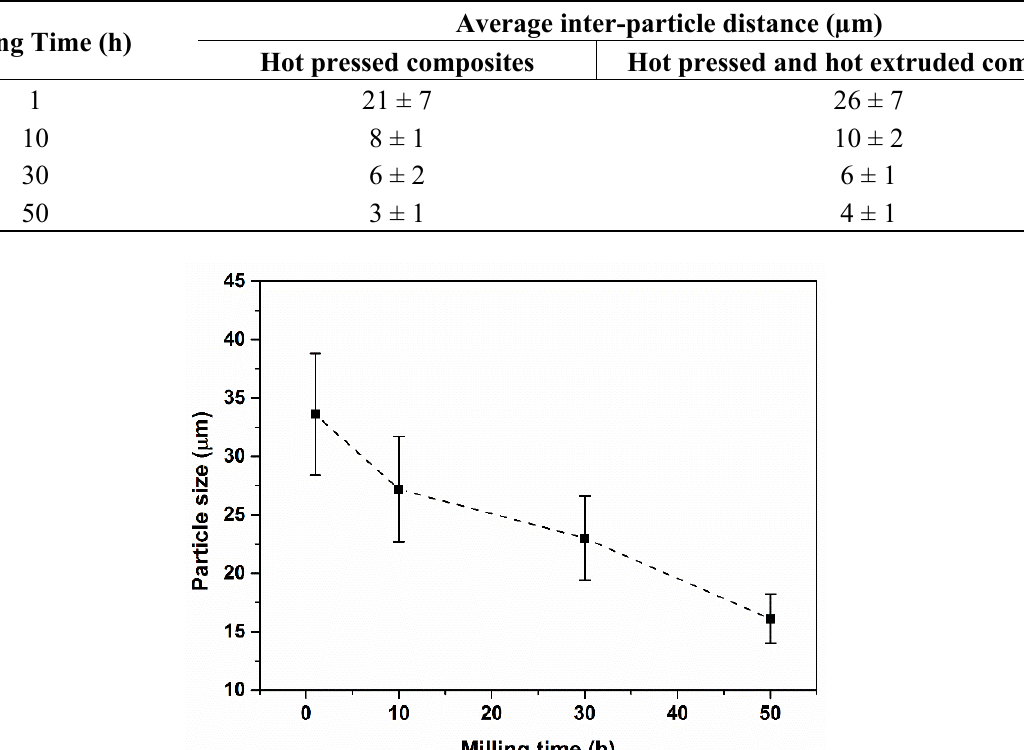
Table 2. The average inter-particle distance for the hot pressed and hot pressed and hot extruded composites as a function of milling time.